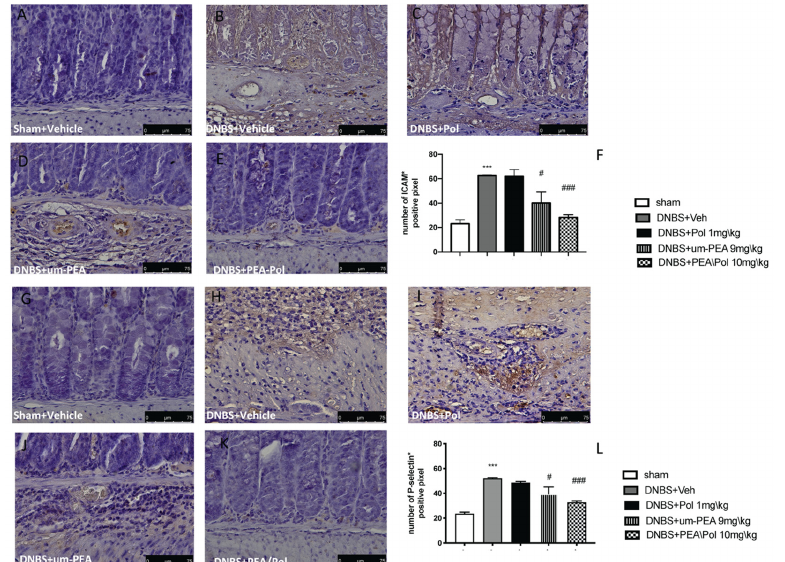
Figure 5. The effects of PEA/Pol on P-selectin and ICAM-1 expression after DNBS injection. Immunohistochemistry for ICAM-1 was evaluated in sham ( A ), DNBS+Veh ( B ), DNBS+Pol ( C ), DNBS+um-PEA ( D ), and DNBS+PEA/Pol ( E ). The results are expressed as % of positive pixels ( F ). Images are figurative of at least three independent experiments. Im- munohistochemistry for P-selectin was evaluated in sham ( G ), DNBS+Veh ( H ), DNBS+Pol ( I ), DNBS+um-PEA ( J ), and DNBS+PEA/Pol ( K ). The results are expressed as % of positive pixels ( L ). Images are figurative of at least three inde- pendent experiments. Values = means ± SEM of six animals in each group; *** p < 0.001 vs. sham; # p < 0.01 vs. DNBS, ### p < 0.001 vs. DNBS.